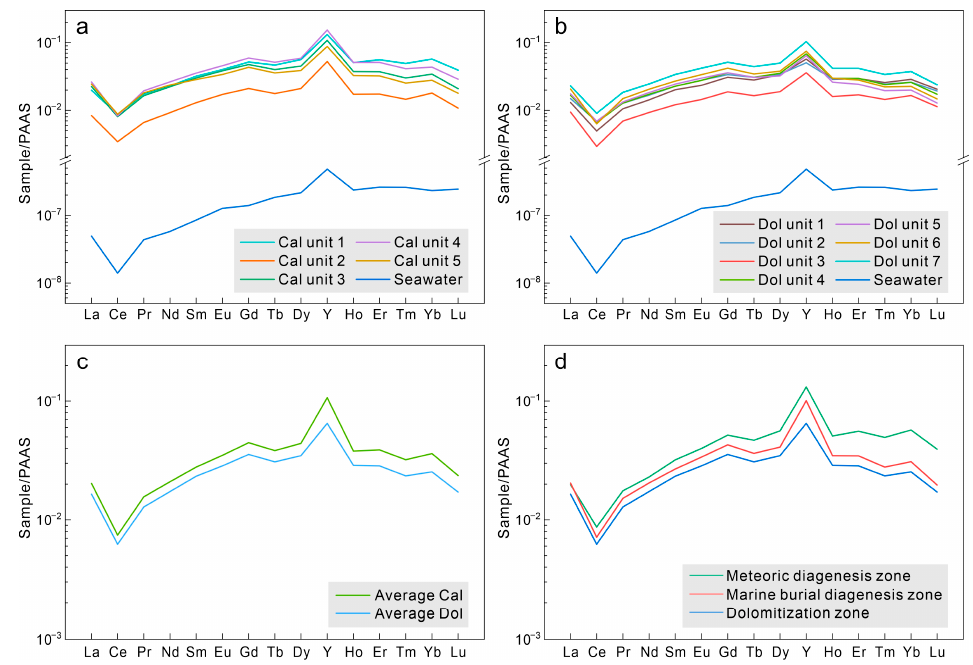
Figure 7. ( a ) PAAS-normalized REY distribution patterns of carbonate samples from the calcite units in the XK-1 core in comparison with modern seawater. ( b ) PAAS-normalized REY distribution patterns of the dolomite unit samples. ( c ) Comparison of PAAS-normalized REY patterns in average calcite with average dolomite. ( d ) Average REY patterns comparison in different diagenesis zones of the core carbonates. Cal: calcite, Dol: dolomite. Seawater value is calculated from the average REY value of 100 m deep modern seawater in the South China Sea [73].